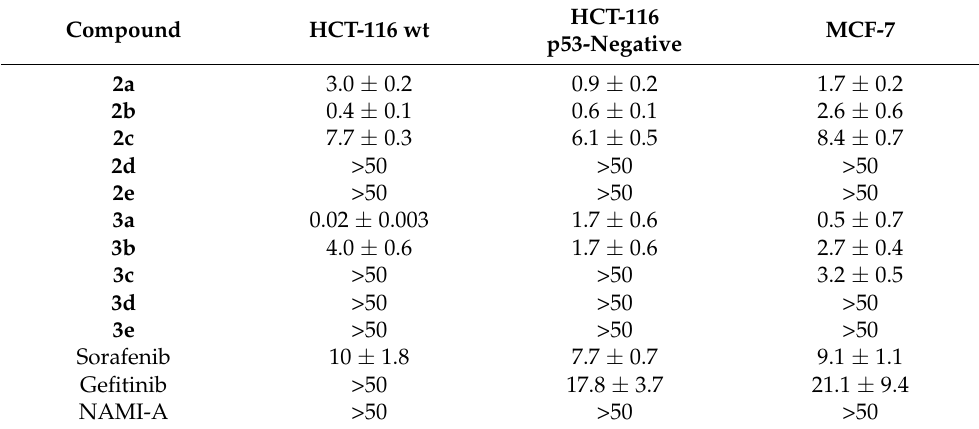
Table 1. Inhibitory activities (IC 50 values in µ M after 72 h of incubation) 1 of compounds 2a – e